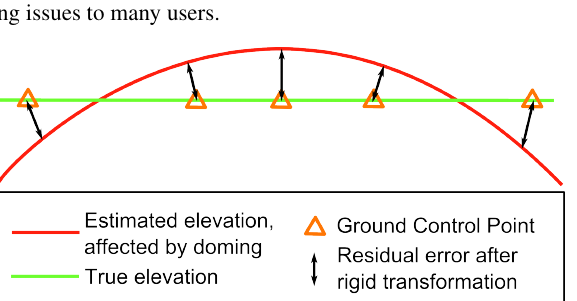
Figure 1. Conceptual figure of the doming effect for an under-estimated focal length. After a rigid transformation, the mean residual error in elevation for the GCPs is equal to 0, but a strong RMS error